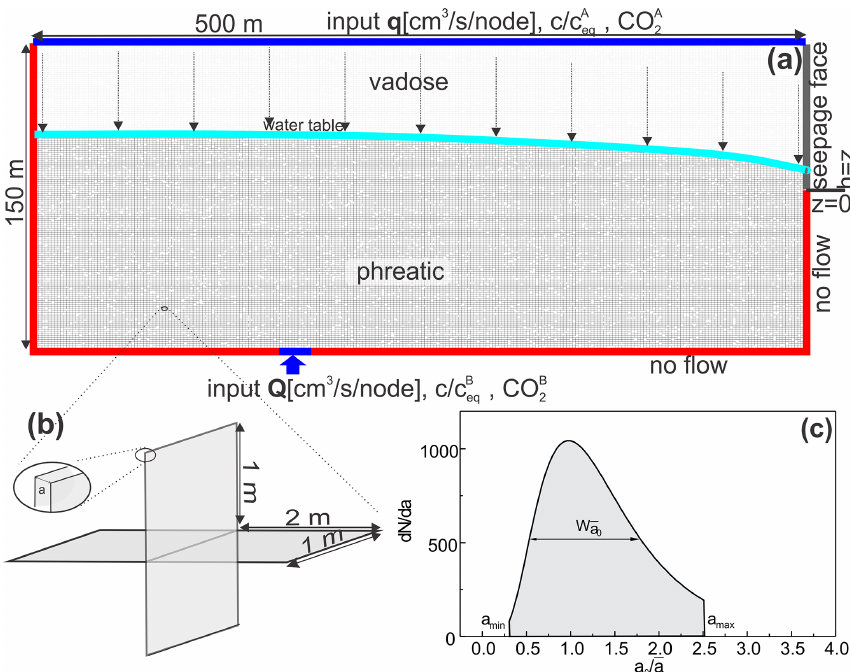
Figure 1. (a) Two-dimensional fracture network presenting a vertical cross section through an unconfined aquifer. The length of the domain is 500m, and the depth is 150m. Fracture spacing is 2 × 1m 2 as depicted in (b) . Input q , cm 3 s − 1 node − 1 , at the top is evenly distributed meteoric water percolating to the water table. When it arrives there, it has become saturated with respect to calcite and p CO . At the bottom 2 of the domain, deep-seated upwelling water enters with prescribed flow Q , cm 3 s − 1 node − 1 by forced flow. Due to dissolution of limestone on its way from below, this water is saturated with respect to calcite and high p CO . The water flows to a seepage face located above height 2 z = 0. Red border denotes no-flow conditions, and blue border denotes input of prescribed flow. Each fracture has an initial aperture width a , which is selected from a truncated log-normal distribution, shown in (c)